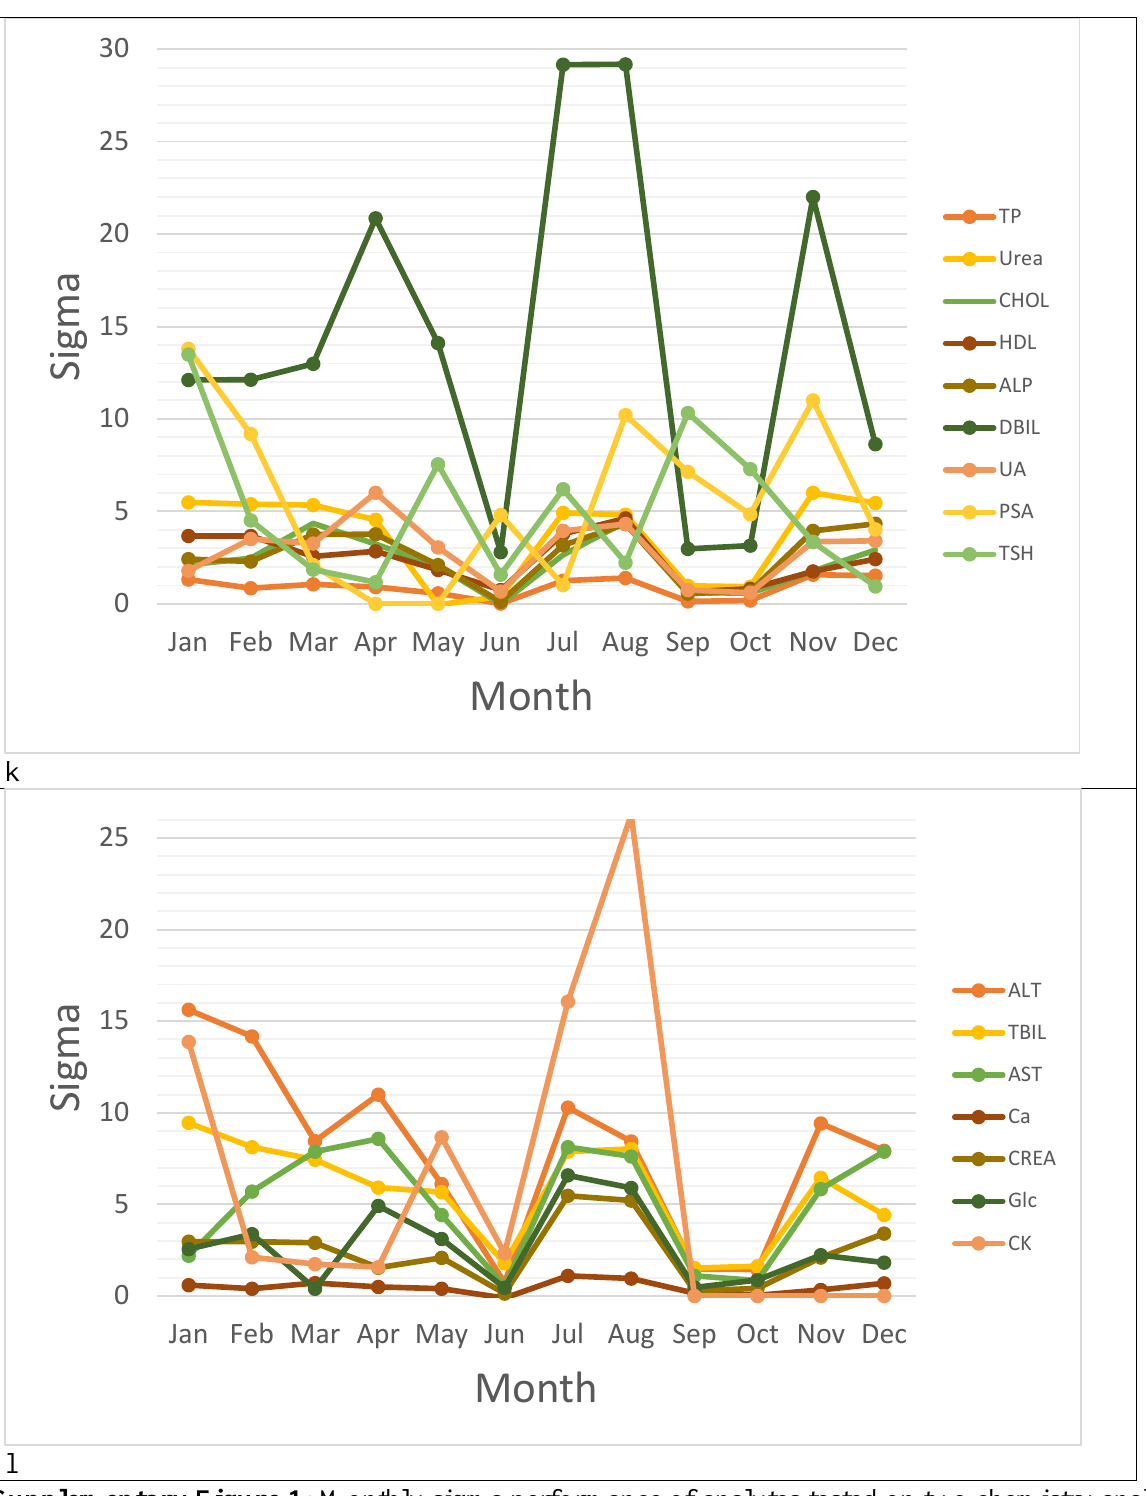
Supplementary Figure 1: Monthly sigma performance of analytes tested on two chemistry analysers grouped according to Analyser and control level, Johannesburg, South Africa, January 2017 – December 2017. (a-c) Analyser 1 Level 1 (d-f) Analyser 1 Level 2 (g-i) Analyser 2 Level 1 (j-k) Analyser 2 Level